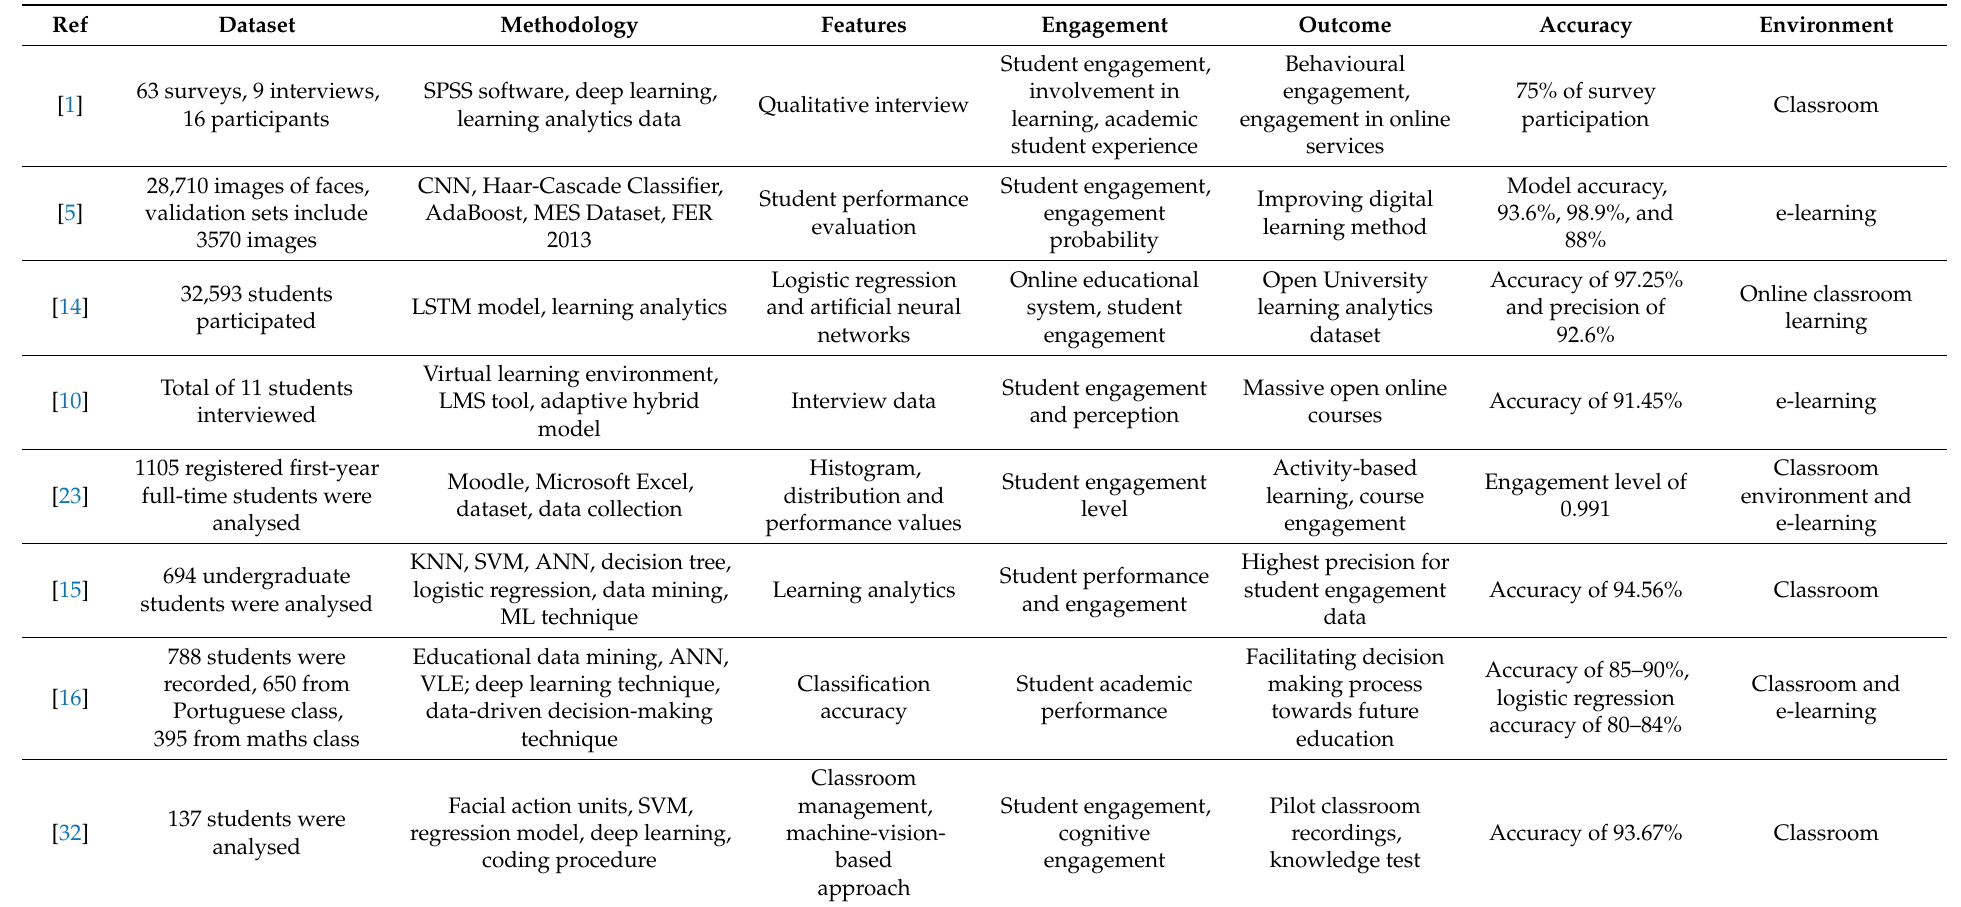
Table 1. List of Past Paper References with Methodology Used and